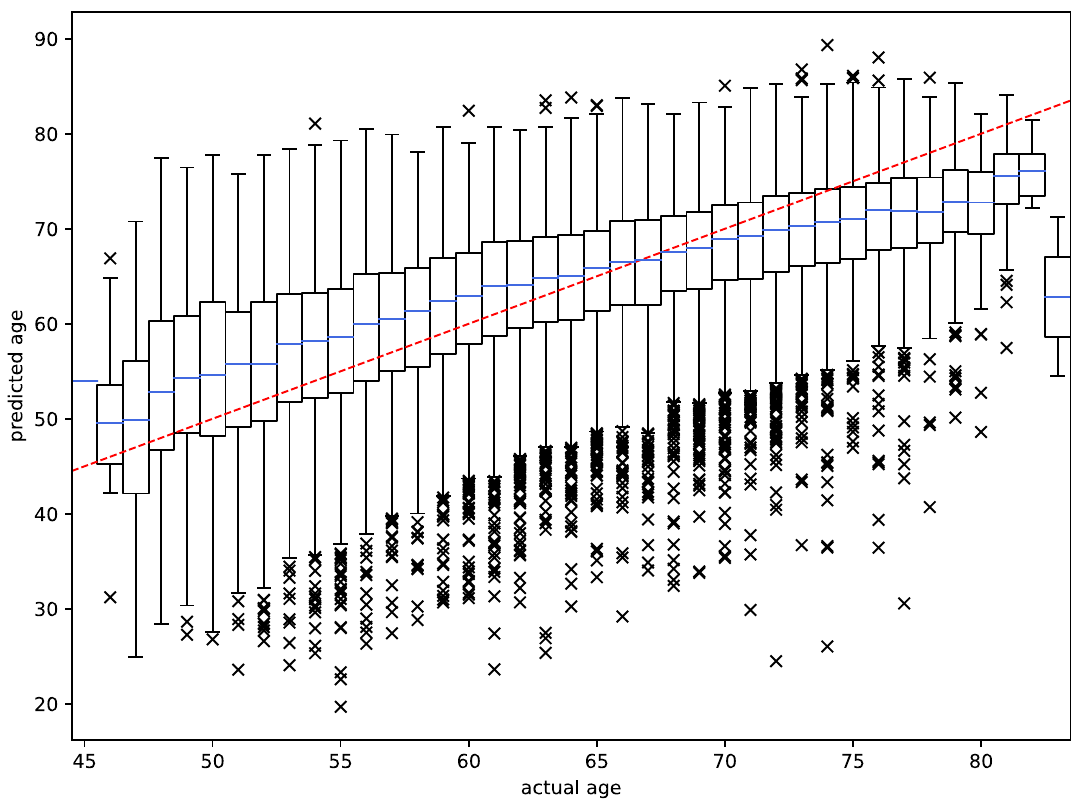
Figure 1. ECG-derived age vs. chronological age for 36,349 participants of the UKB. The Pearson correlation coefficient was 0.53. The red dashed line illustrates a perfect fit. Data is grouped into boxes as the chronological age at the time of recording the ECG was only available as the number of years. Note that ranges and scales are different between the x- and y-axis due to outliers in the predicted age being considerably outside the range of the chronological age in the cohort. Box plot features: blue centre lines, median; box limits, first and third quartile; whiskers, 1.5 × inter-quartile range; markers, outliers.